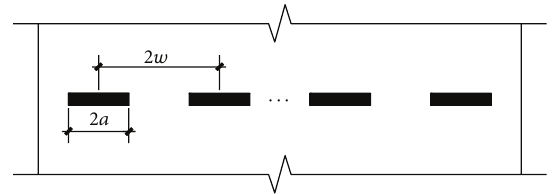
Figure 2: Model of penetrated crack in infinite